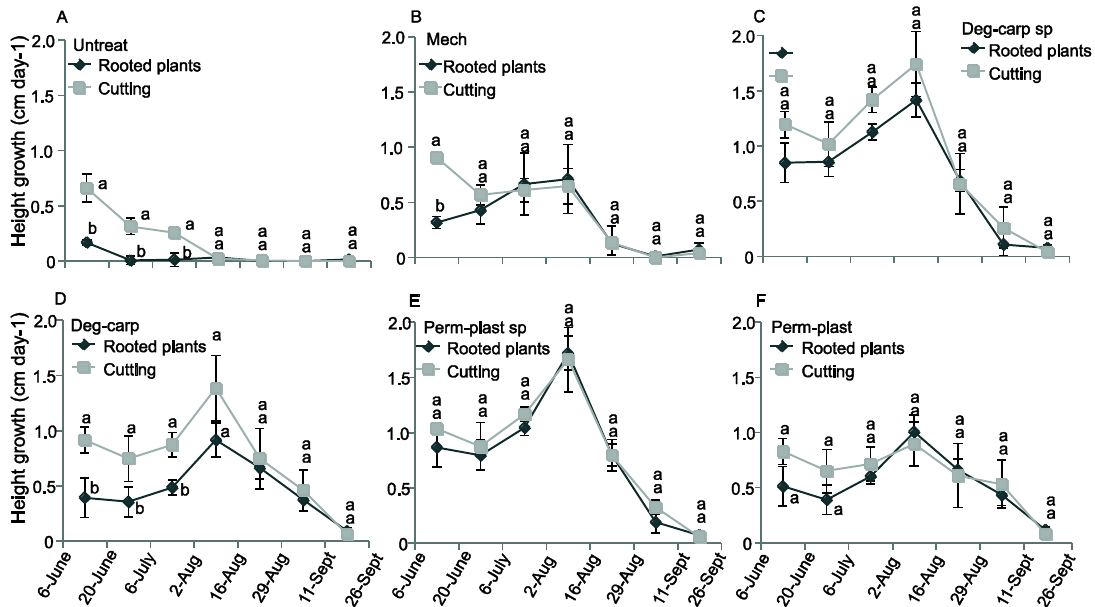
Figure 2. Height growth rate during the first year after planting. Height growth rate during the first year, in cm per day, for rooted cuttings and un-rooted plants grown under each of the treatments: control (Untreat), mechanical vegetation control (Mech), mulching without soil preparation using degradable carpet (Deg-carp) or permanent polypropylene plastic (Perm-plast), and with soil preparation (Perm-plast sp and Deg-carp sp). Values with the same letter are not significantly different at the p = 0.05 level: means ( n = 3), error bars indicate standard